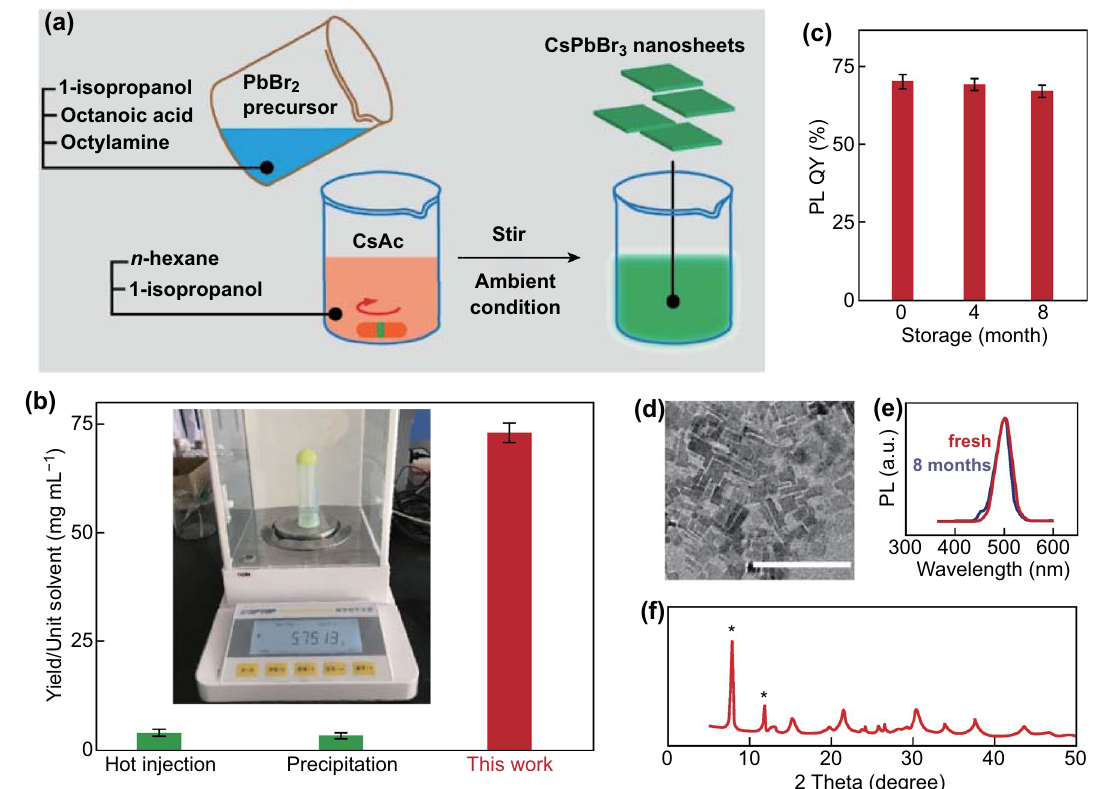
Fig. 1 a Schematic showing the synthetic procedure of ultra-stable CsPbBr 3 NCs. b Reaction yield comparison between this experiment and conventional methods, such as hot-injection and precipitation. The inset shows 5.75 g of as-synthesized nanosheets generated in a 100-mL beaker. c PL QY measurements of both fresh and aged (stored in a capped vial) colloidal samples, indicating a robust storage stability. The error bar was obtained by three parallel measurements. d TEM image of the nanosheets. Scale bar represents 100 nm. e PL spectra of fresh and aged samples, showing no significant difference. f XRD pattern of self-assembled nanosheets, showing a cubic phase. The peaks marked with aster- isks indicate the inter-plane spacing of assembled